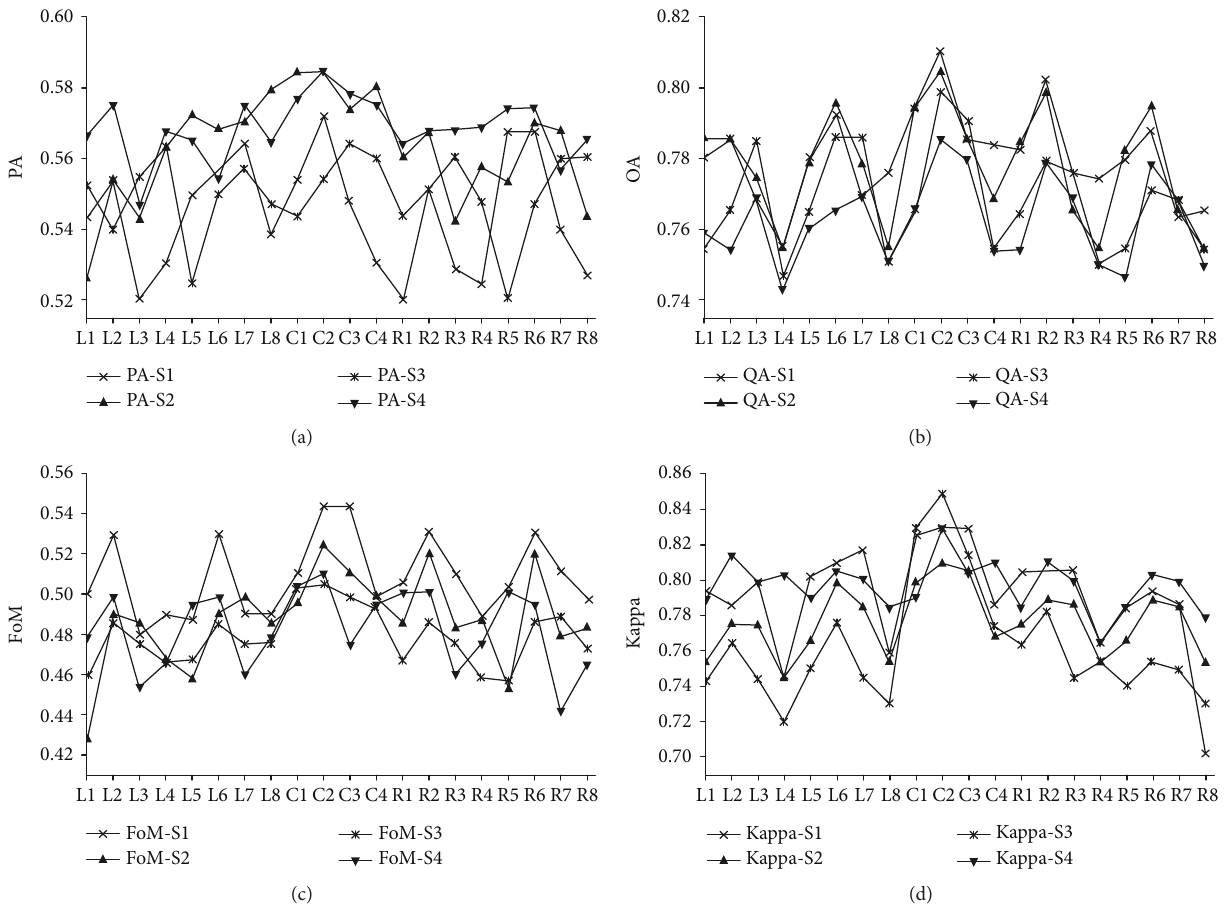
Figure 4: In fl uence of point a , point b , point c , and point d values for the simulation accuracy of S1, S2, S3, and S4 at four cell neighborhoods. L1, L2, L3, and L4 and L5, L6, L7, and L8 are the veri fi cation results of two points at the left end of C 0 in di ff erent cell neighborhoods: R1, R2, R3, and R4 and R5, R6, R7, and R8, respectively. Veri fi cation results of two points on the right side of C in di ff erent cell neighborhoods, where 1 and 5 represent 3m × 3m neighbors; 2 and 6 represent 5 m × 5m neighbors; 3 and 7 represent 7 m × 7 m Cell neighborhood; 4 and 8 represent 9m × 9m cell